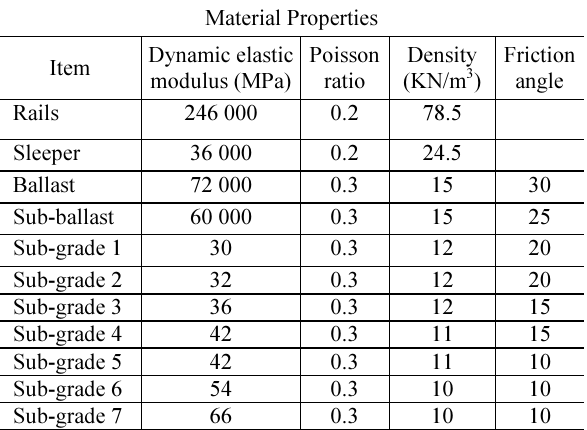
Table 3. Variation of maximum vertical acceleration for selected